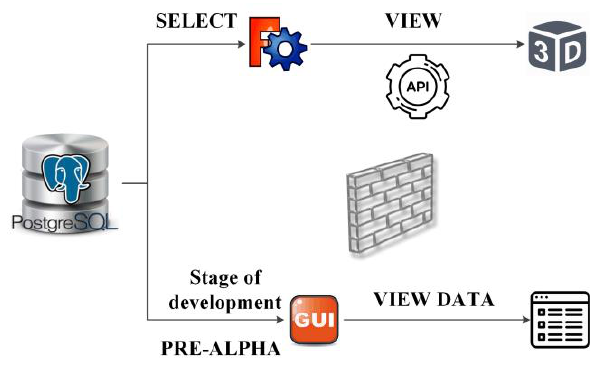
Figure 12: How to access IFC data in